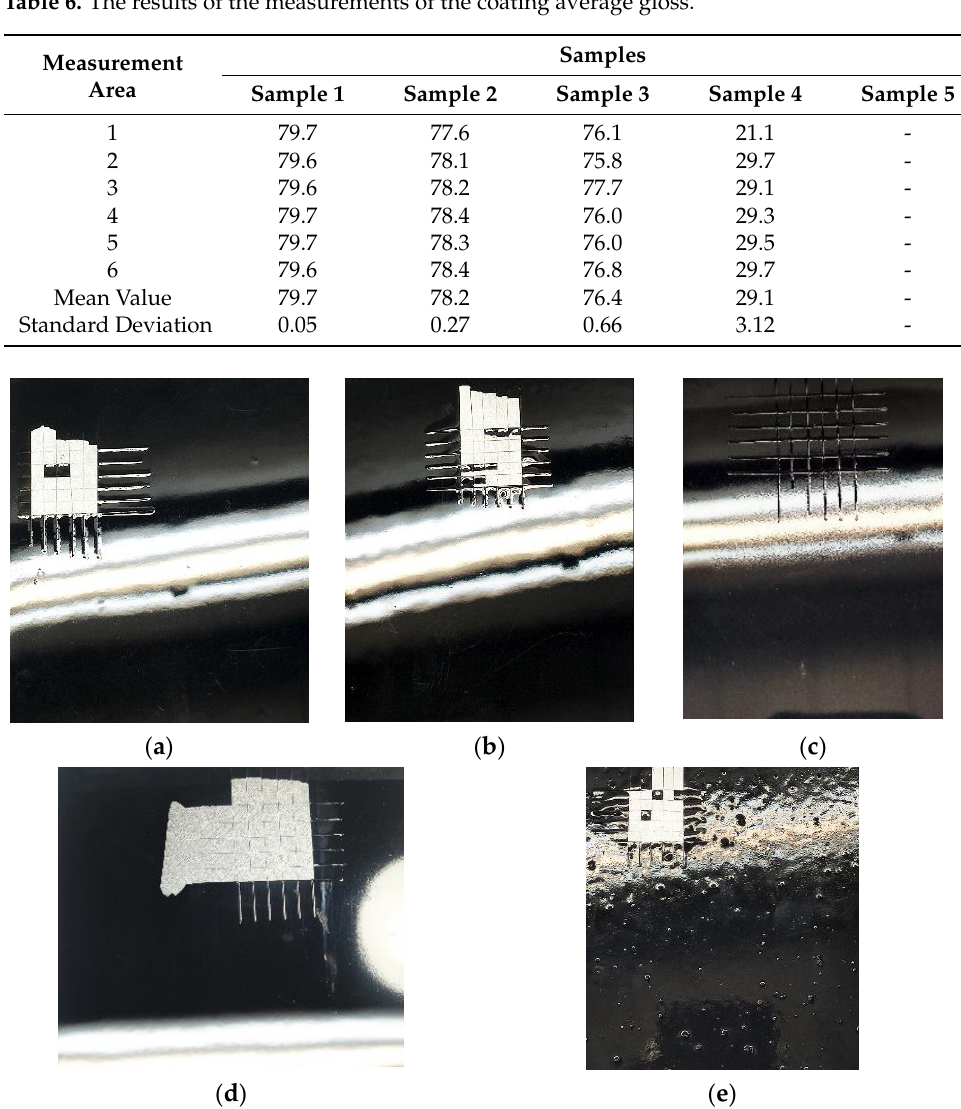
Figure 5. Results of lacquer adhesion tests using the cross-cut method; ( a ) series 1, ( b ) series 2, ( c ) series 3, ( d ) series 4 and ( e ) series 5.